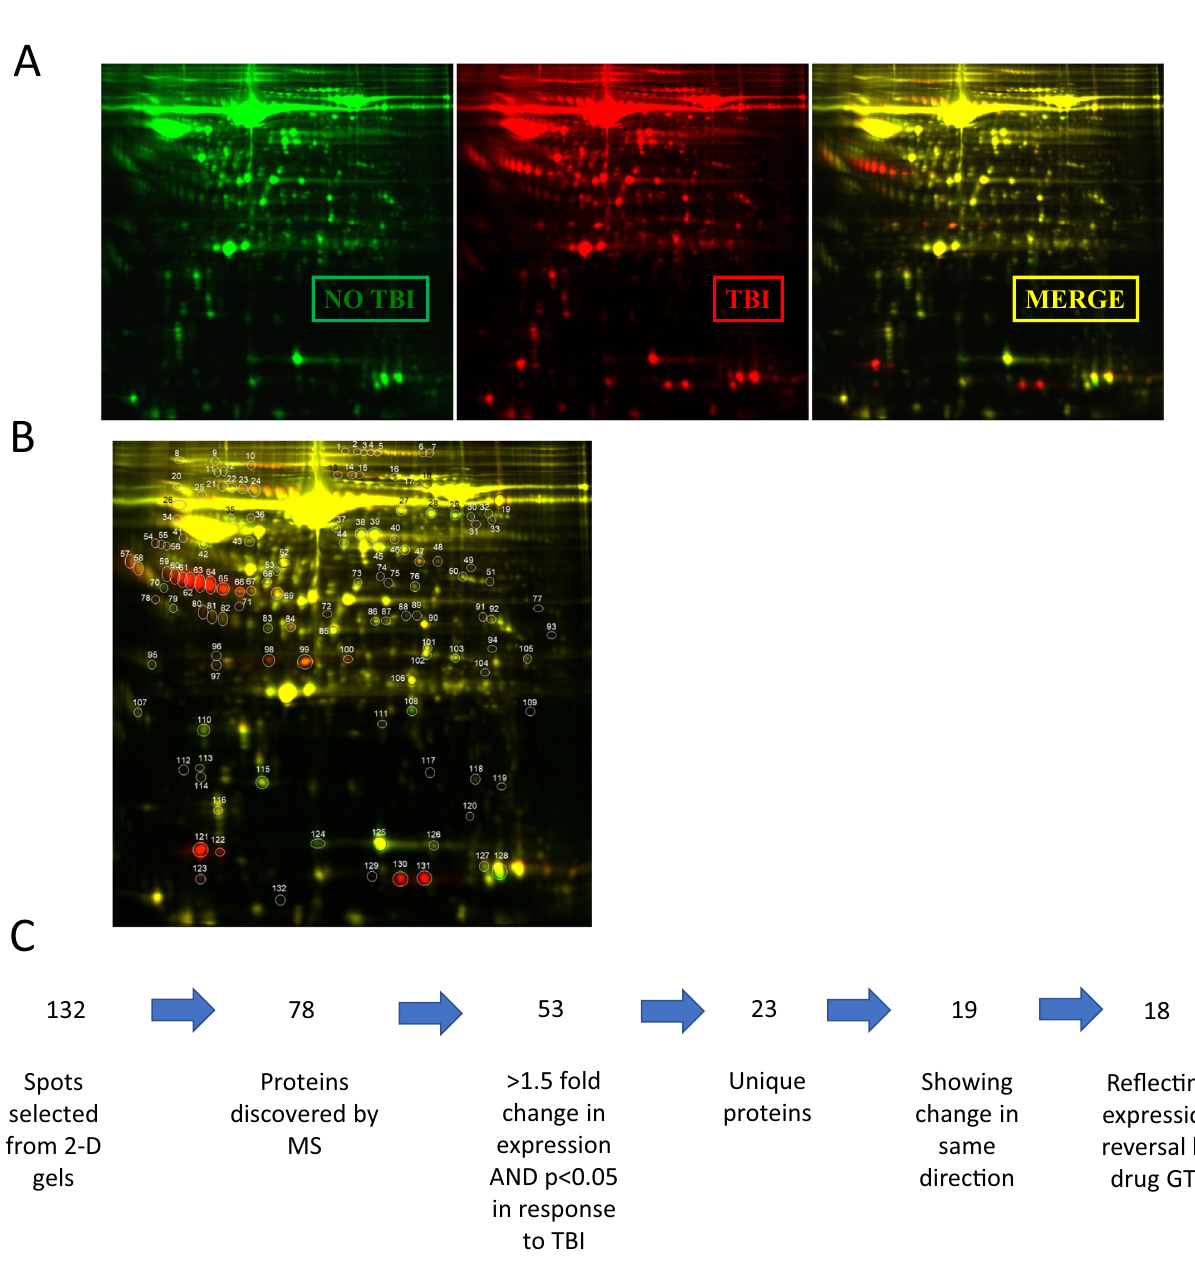
Figure 3. Detection and selection process for identifying proteins for proteomic analysis. ( A ) Lysine groups of serum proteins from three experimental samples were directly labeled with cyanine CyDye DIGE Fluor and run on same gel for 2D analysis. ( B ) Individual protein spots detected by selection software. ( C ) Proteins identified by MS were screened for change in expression, statistical significance, consistency in expression change, and